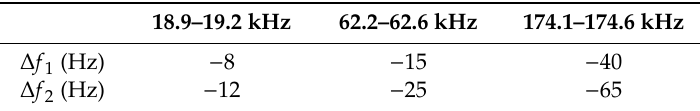
Table 4. The frequency shifts at different frequencies bands.